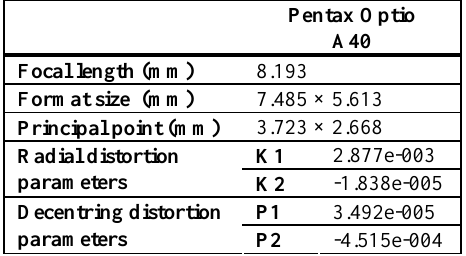
Table 1. Internal parameters of the Pentax Optio A40 camera